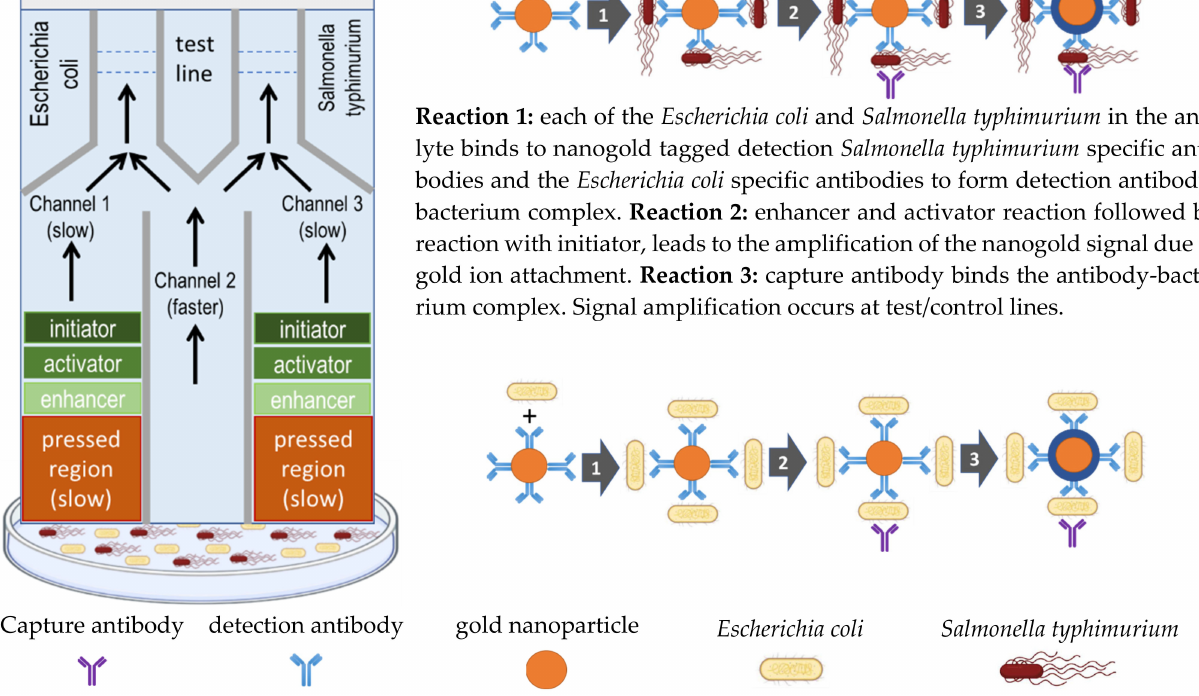
Figure 14. The operational principle of the paper-based nanogold-linked immunoassay dipstick reported by Park et al., (2016) showing the multi-speed multi-channel design. The pre-immobilized capture antibodies at the test line give the gold ion amplified signal when the gold ions are attached to the mobilized nanogold of the nanogold tagged detection antibody with pathogens from the fast flow rate channel